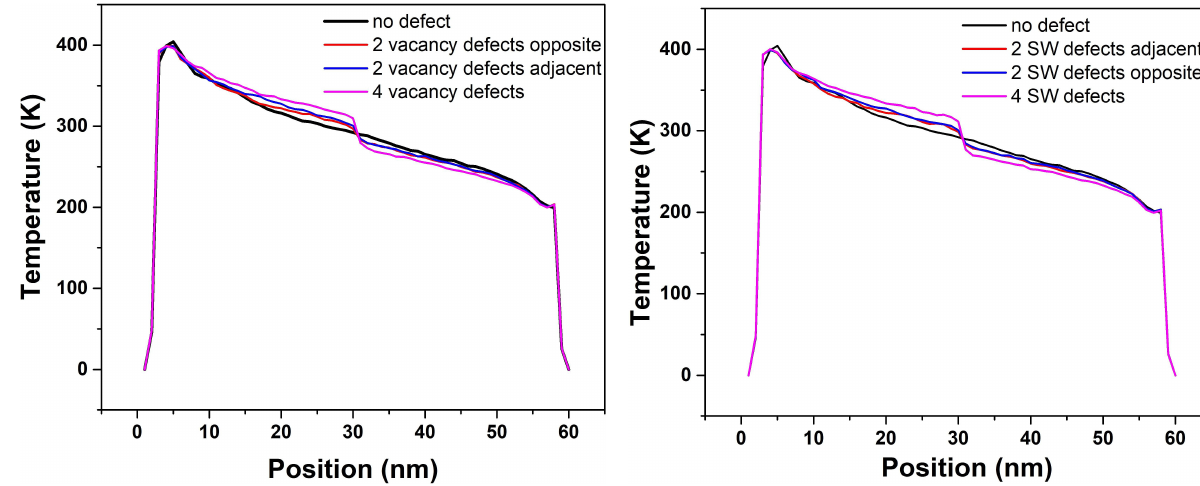
Figure 2: The average temperature of the inner tube varying with the position of the mass center